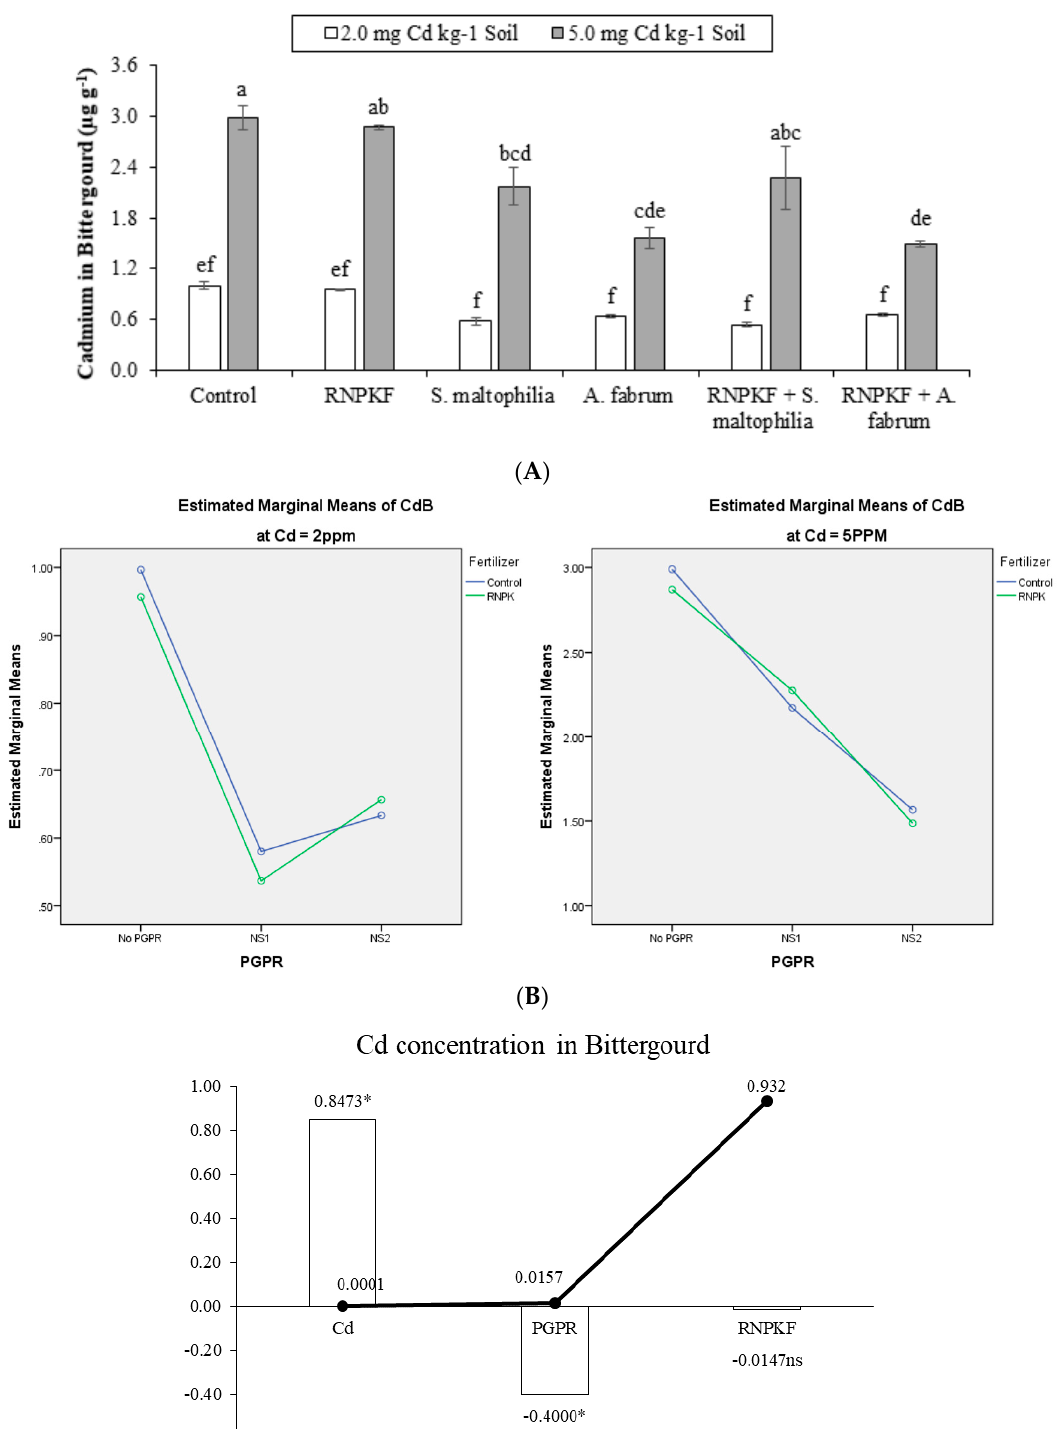
Figure 7. Effect of rhizobacteria with and without recommended NPK fertilizer on Cd in bitter gourd (CdB) under Cd ( A ). Interaction graph of PGPR (NS1 = S. maltophilia , NS2 = A. fabrum ), RNPKF, and Cd levels for CdB (µg g − 1 ) ( B ). Pearson correlation of CdB with different levels of Cd, ACCD PGPR, and recommended NPK fertilizer where the y -axis represents the values of correlation (bars in the graph) and x -axis probability (lines in the graph) ( C ). * = p ≤ 0.05; ns = p > 0.05 non-significant.